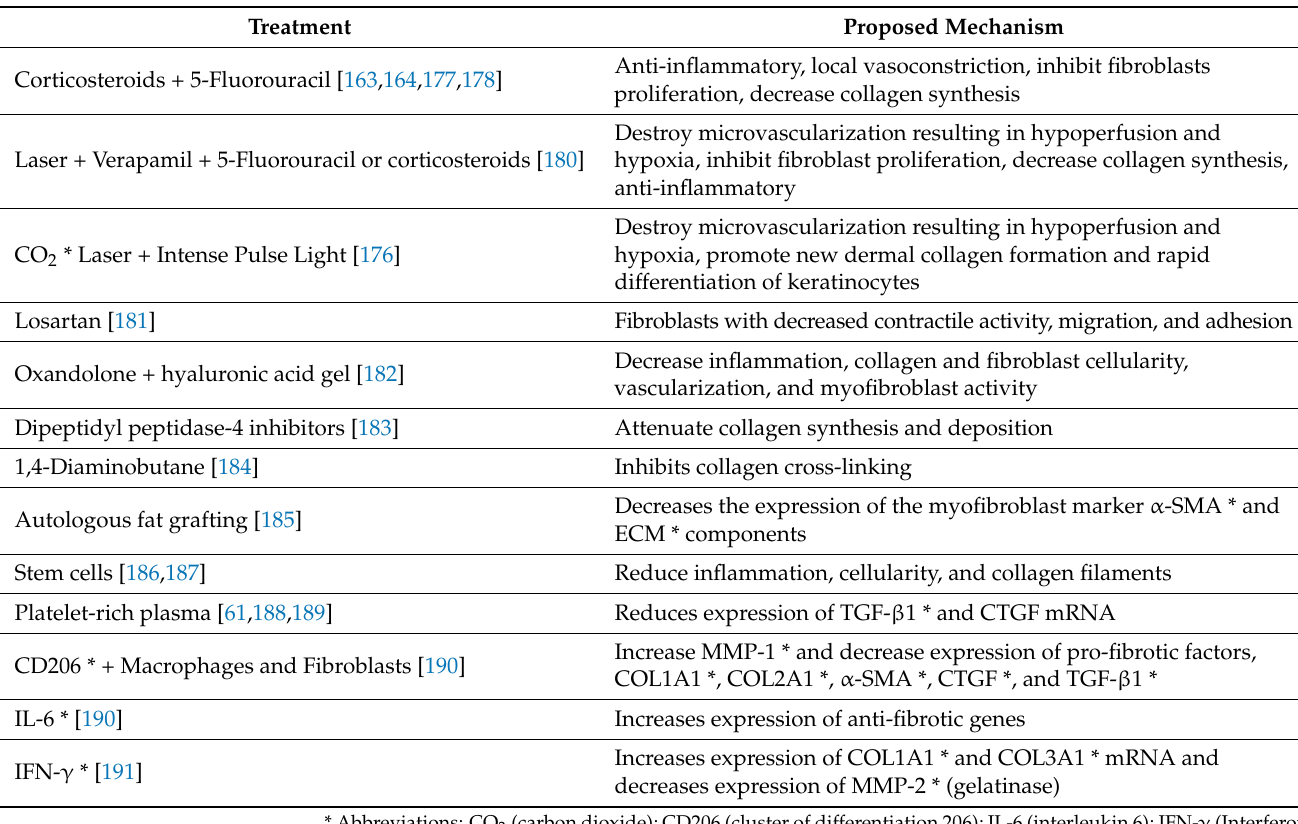
Table 3. Emerging therapeutics for hypertrophic